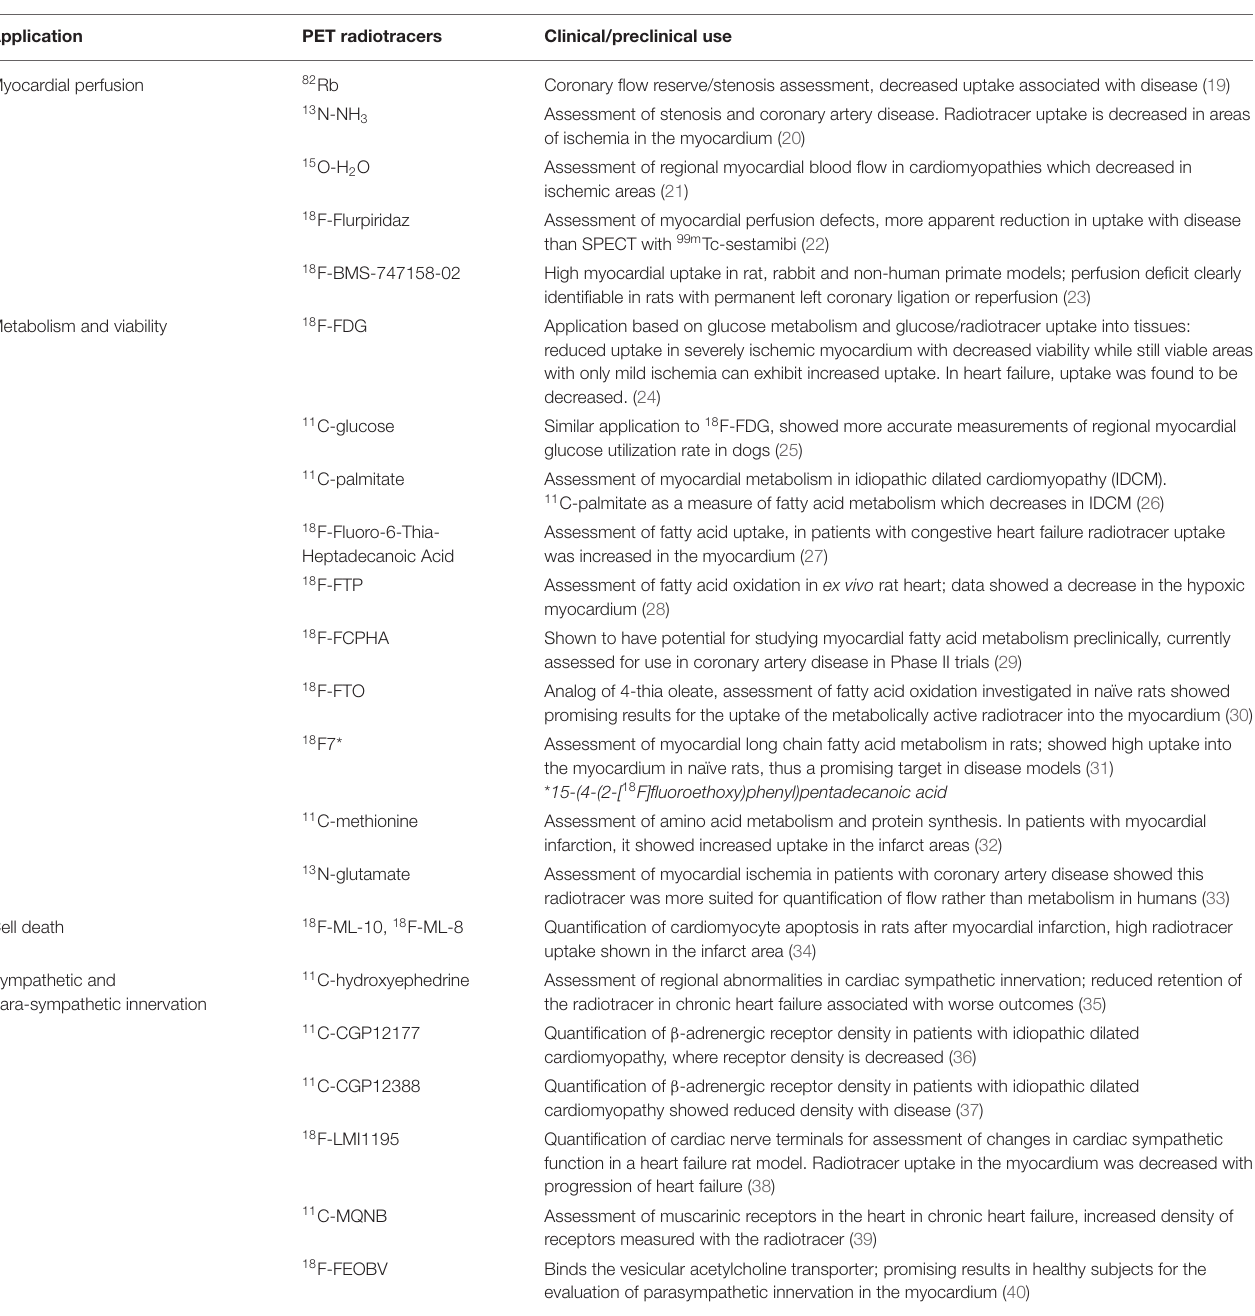
TABLE 1 | Classic PET radiotracers for cardiac imaging